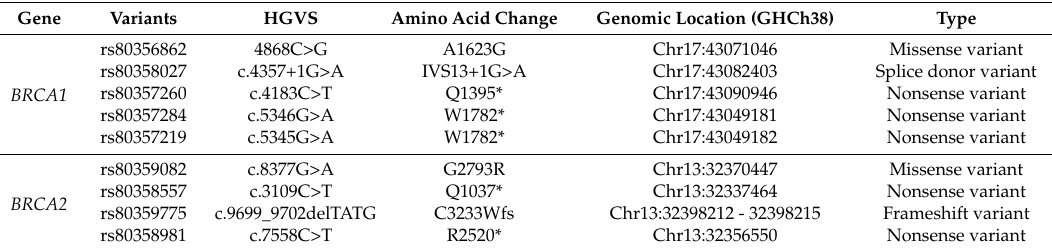
Table 1. Pathogenic variants in BRCA1 and BRCA2 in Mexican ovarian cancer